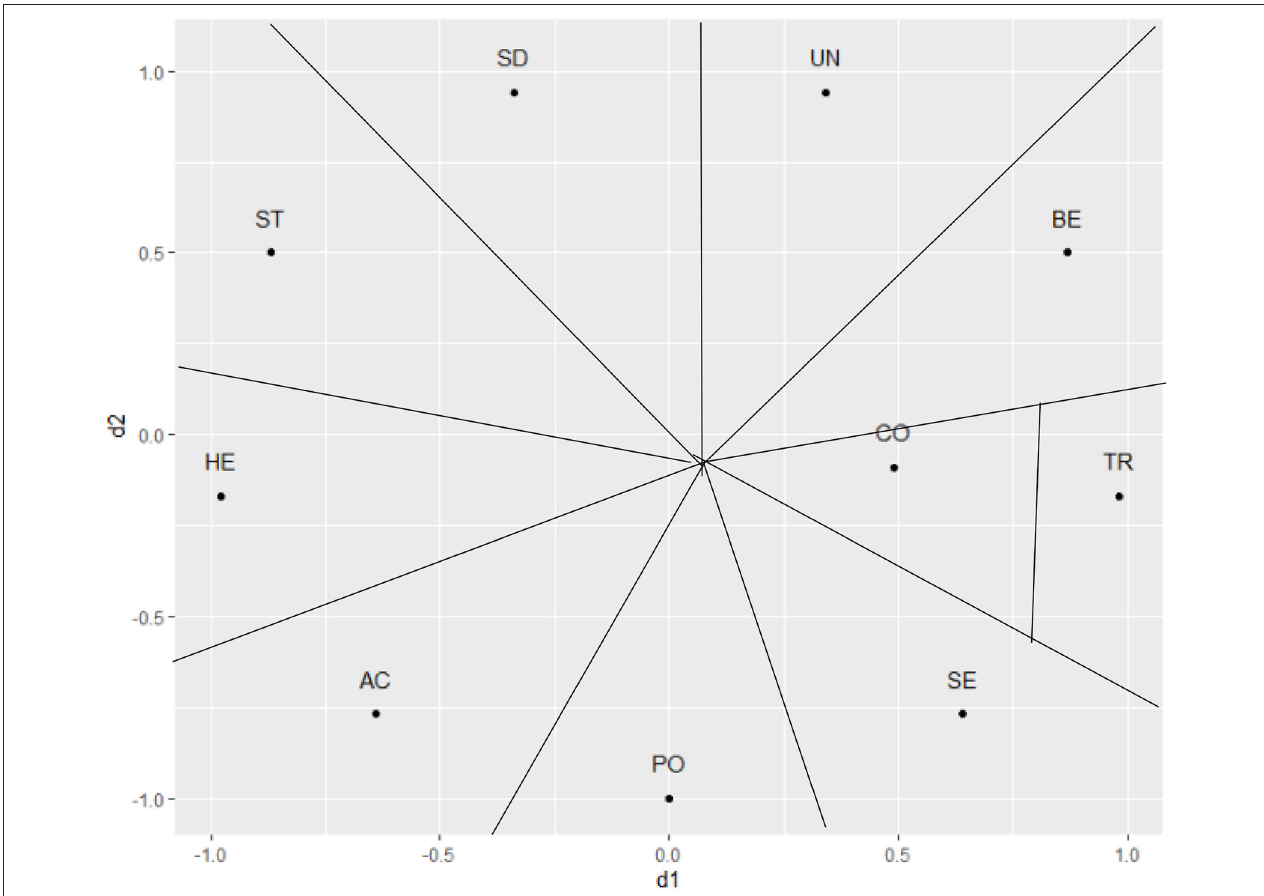
FIGURE 1 | Schematic representation of the Schwartz Value Theory. SD, Self direction; ST, Stimulation; HE, Hedonism; AC, Achievement; PO, Power; SE, Security; TR, Tradition; CO, Conformity; BE, Benevolence; UN,